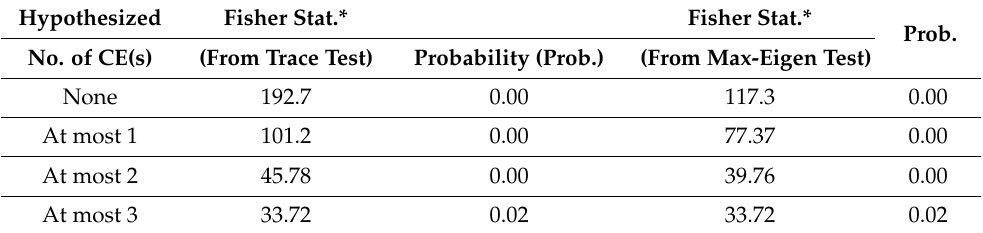
Table 4. Johansen Co-integration. Hypothesized Fisher